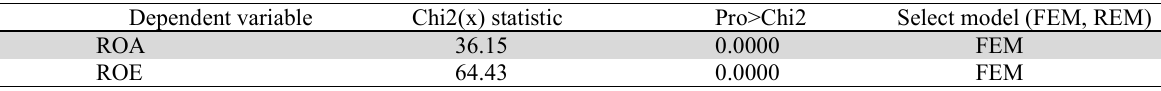
Results of Hausman test between two models REM and FEM Dependent